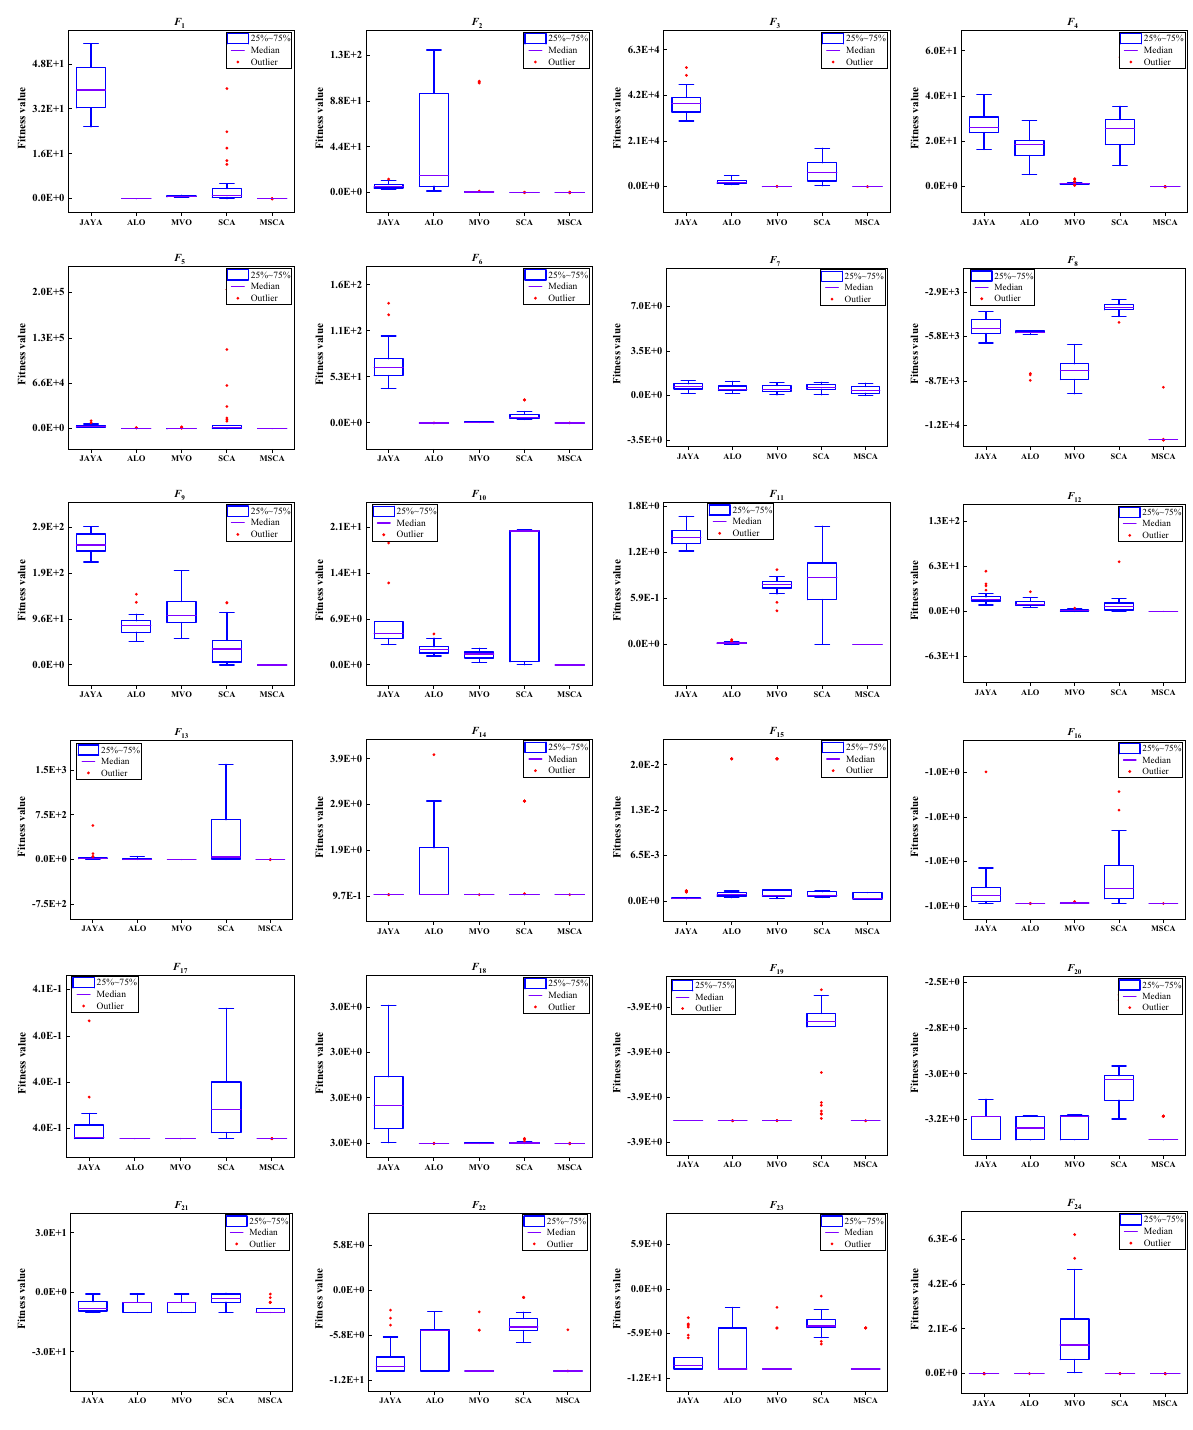
Figure 5. The box-plot of different algorithms on classical benchmark